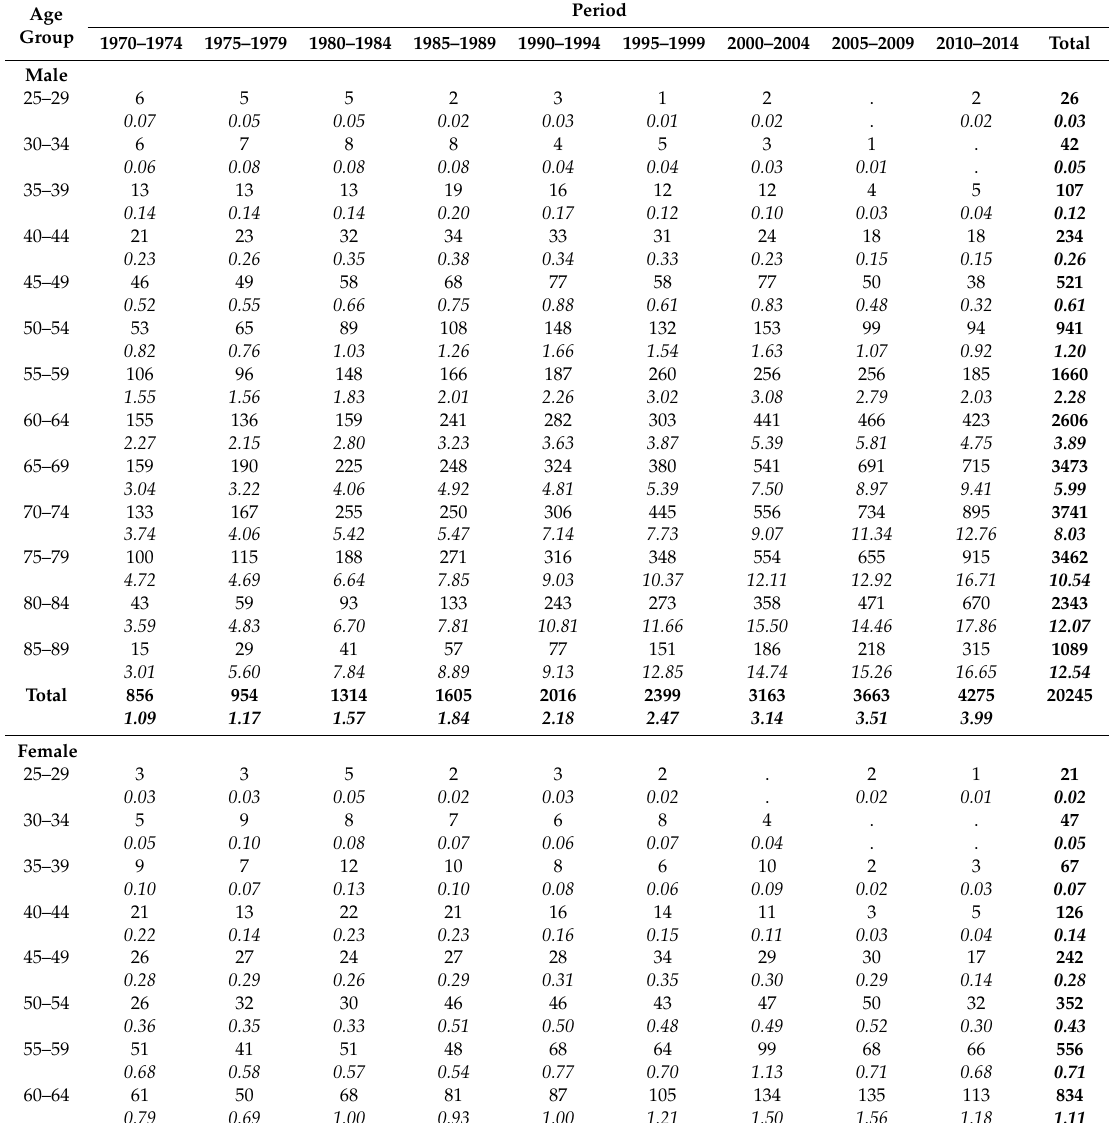
Table 1. Pleural mesothelioma deaths and mortality rates ( × 100,000 person-years) by age and period, Italy,